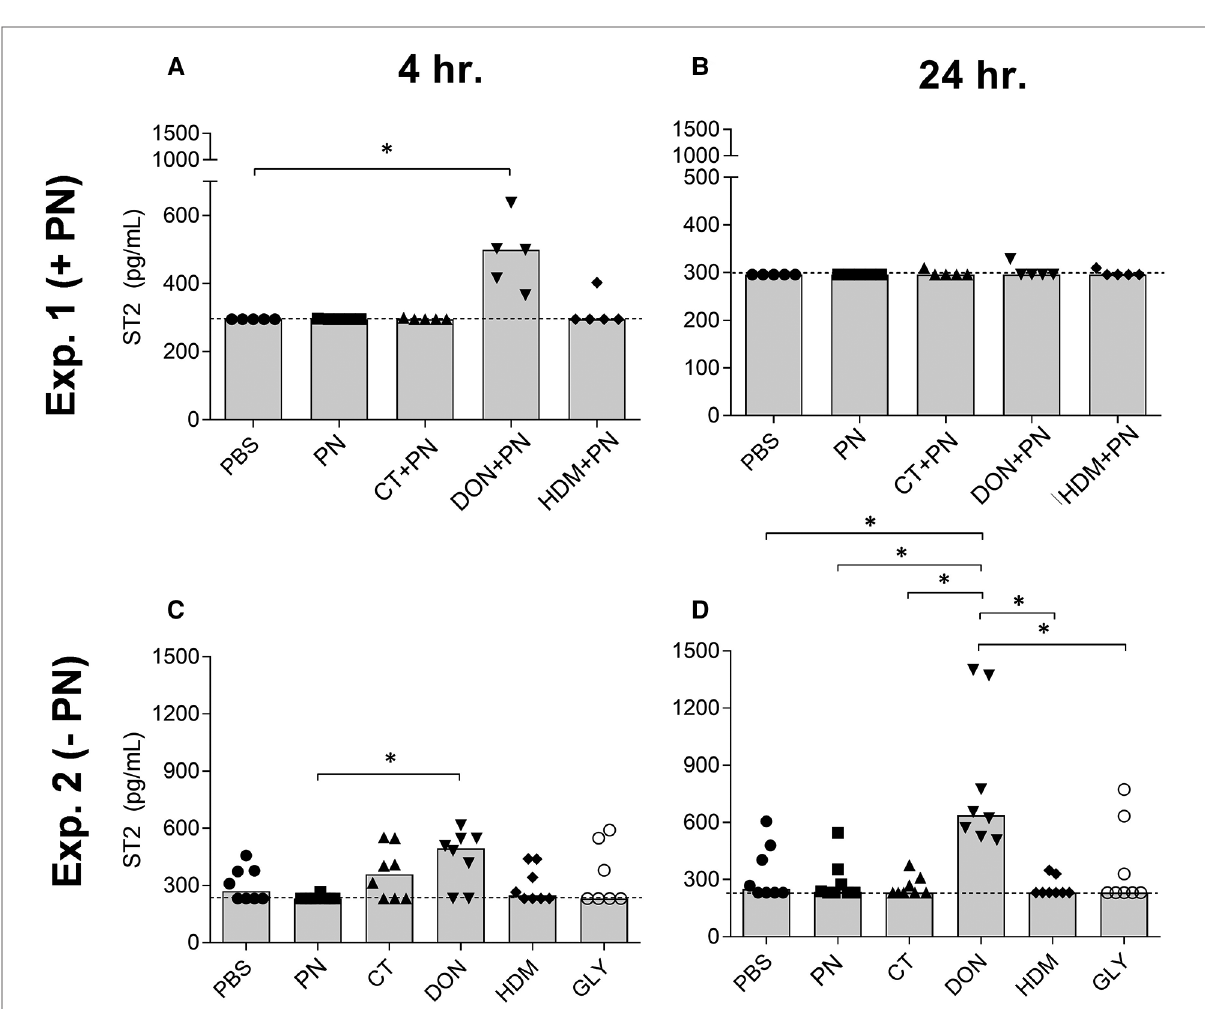
FIGURE 5 ST2 concentrations in serum at 4 h ( A ) and 24 h ( B ) after a single i.g. dose of PBS, PN or a barrier disruptor with PN (exp. 1, n = 5), 4 h ( C ) and 24 h ( D ) after a single i.g. dose of PBS, PN, or a barrier disruptor withour PN (exp. 2, n = 8). Dotted lines represent the lower assay detection limit. Brackets denote statistically signi fi cant differences (* p <0.05, ** p <0.01) between two groups. Columns denote the group median value while each symbol denotes the individual